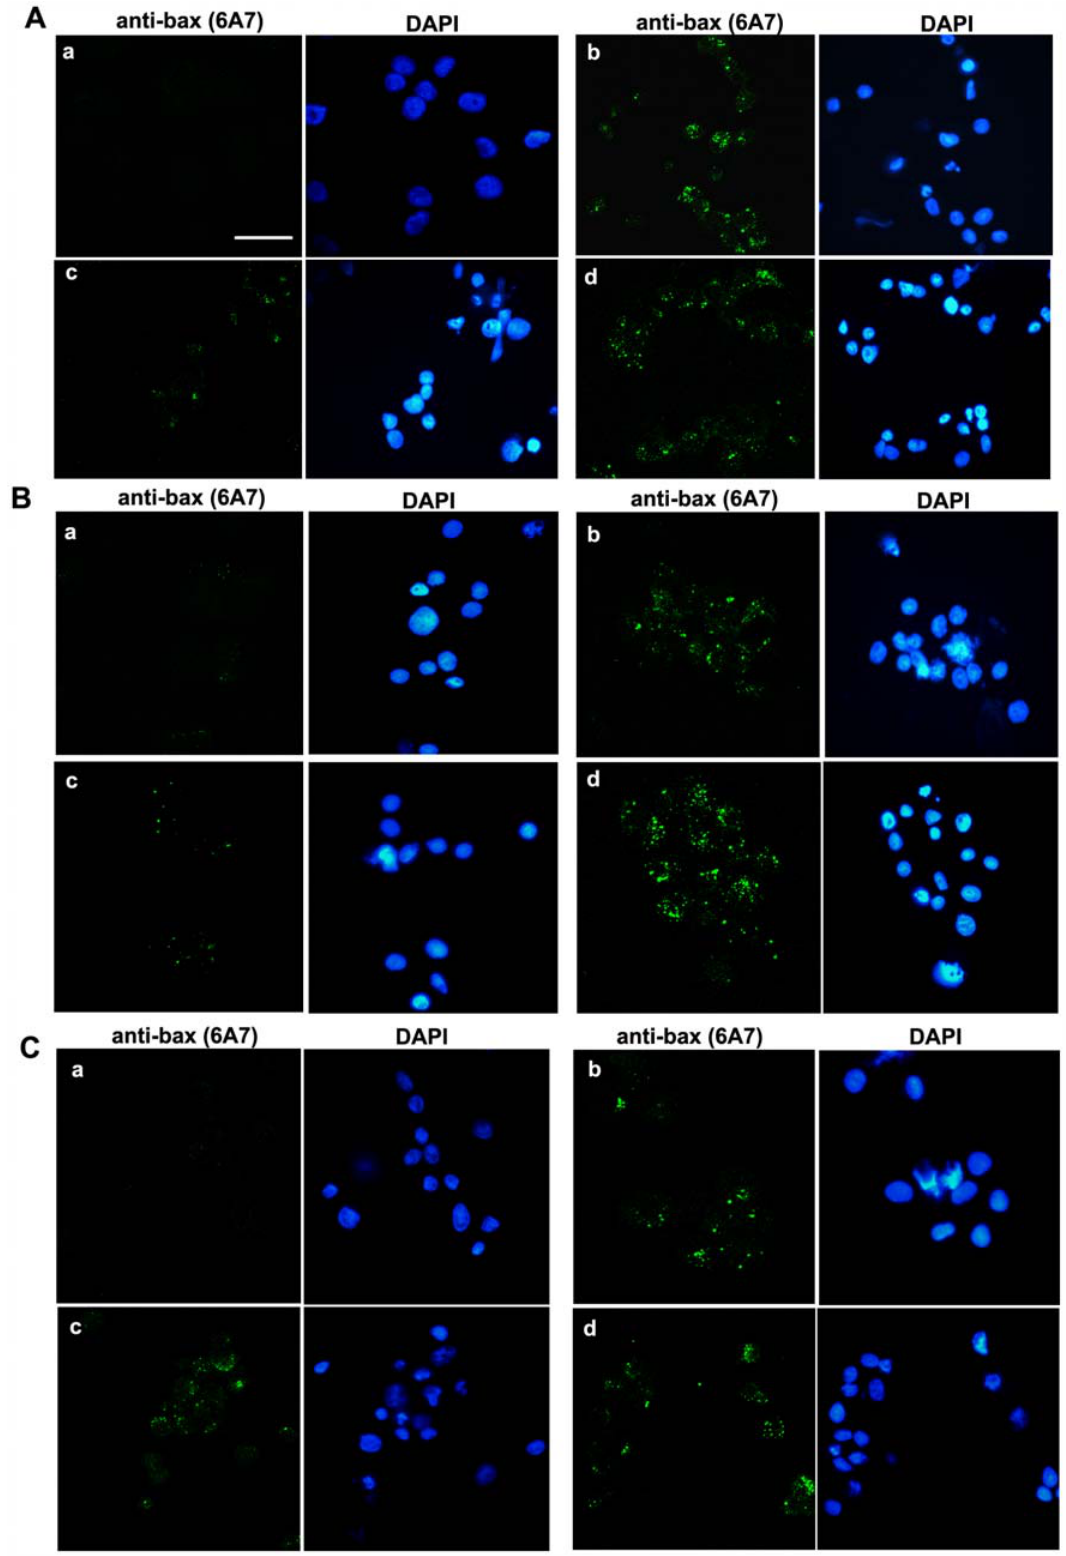
Figure 5. PHE enhances TG-induced apoptosis resistance in DU145 cells also via bax activation. Representative immunofluorescence of (A) DU145, (B) DushCTL and (C) Dushcav-1 cells in (a) non-treated conditions, (b) 10 m M TG for 48 h, (c) 10 m M PHE 3-day pretreatment (d) with the presence of 1 m M PRA, followed by 10 m M TG for 48 h showing the presence of activated Bax recognised by the anti-bax (6A7) antibody. The presence of cells in the observation field is indicated by DAPI-stained nuclei. Bar, 50 m m.